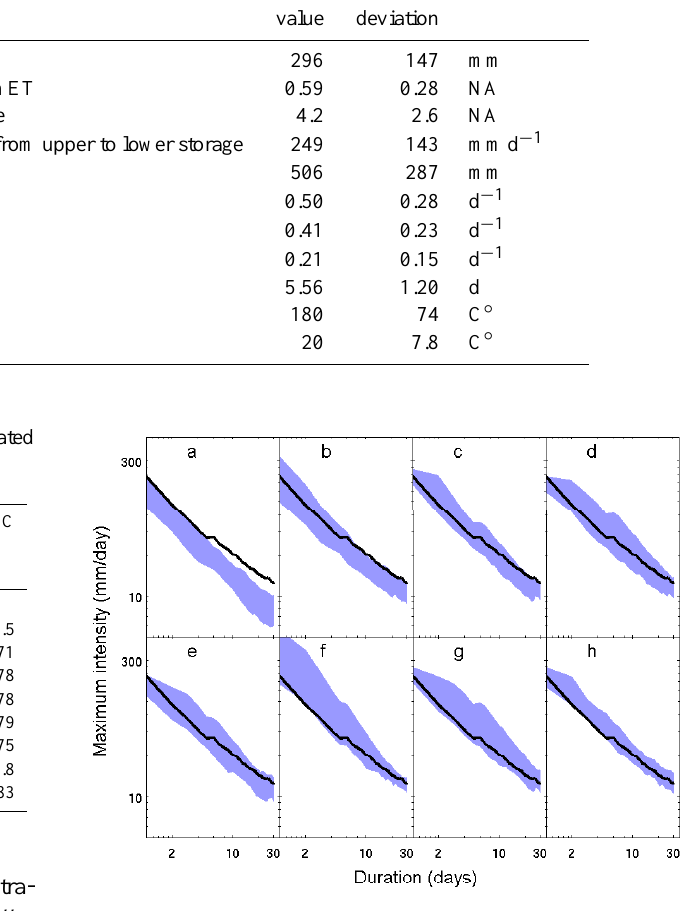
Fig. 5. Intensity-duration curves for the RCM precipitation using (a) raw output and with MOS using (b) DBS, (c) DBS-M, (d) DBS- L, (e) DM, (f) QM, (g) QM-M and (h) QM-L. The black line is observed